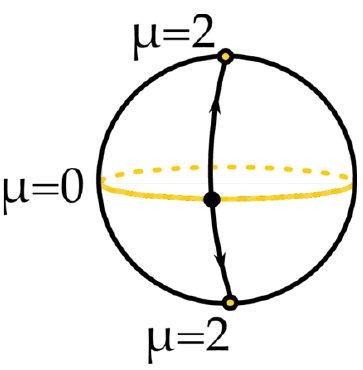
Figure 6 . S 2 with the Morse-Bott function given by f ( x; y; z ) = z 2 . The critical locus is colored in yellow and consists of two critical points of index 2 (north ant south pole) and a critical circle of index 0 (the equatorial circle). The gradient curves are depicted in black. Note that M ( N 0 ; N 2 ) = S 1 ‘ S 1 . These two circles parametrize the gradient trajectories in the upper and lower